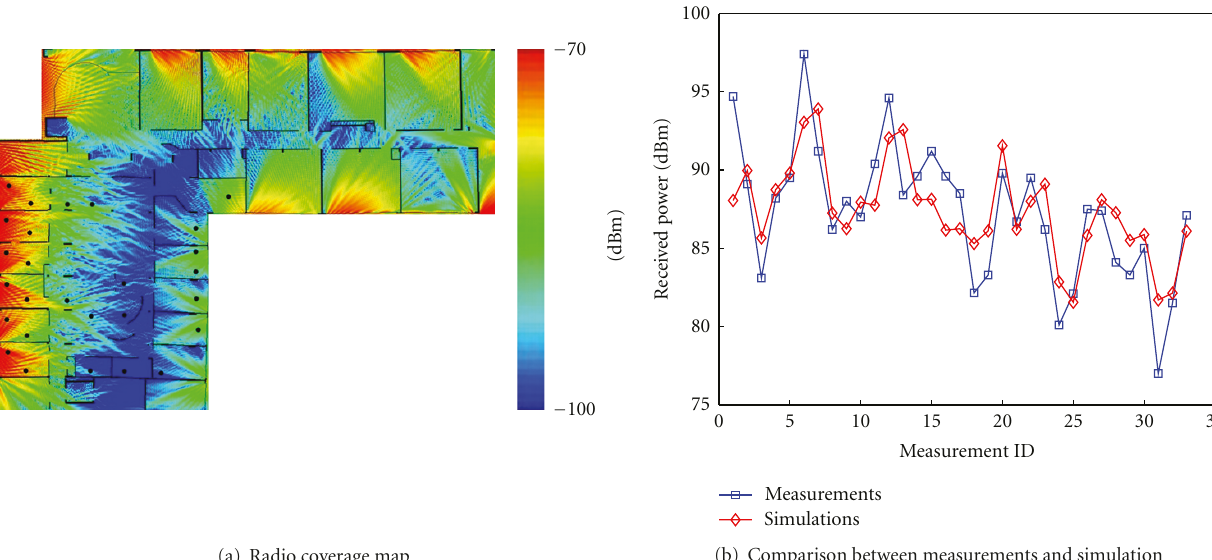
Figure 5: Outdoor to Indoor simulation results (Experiment